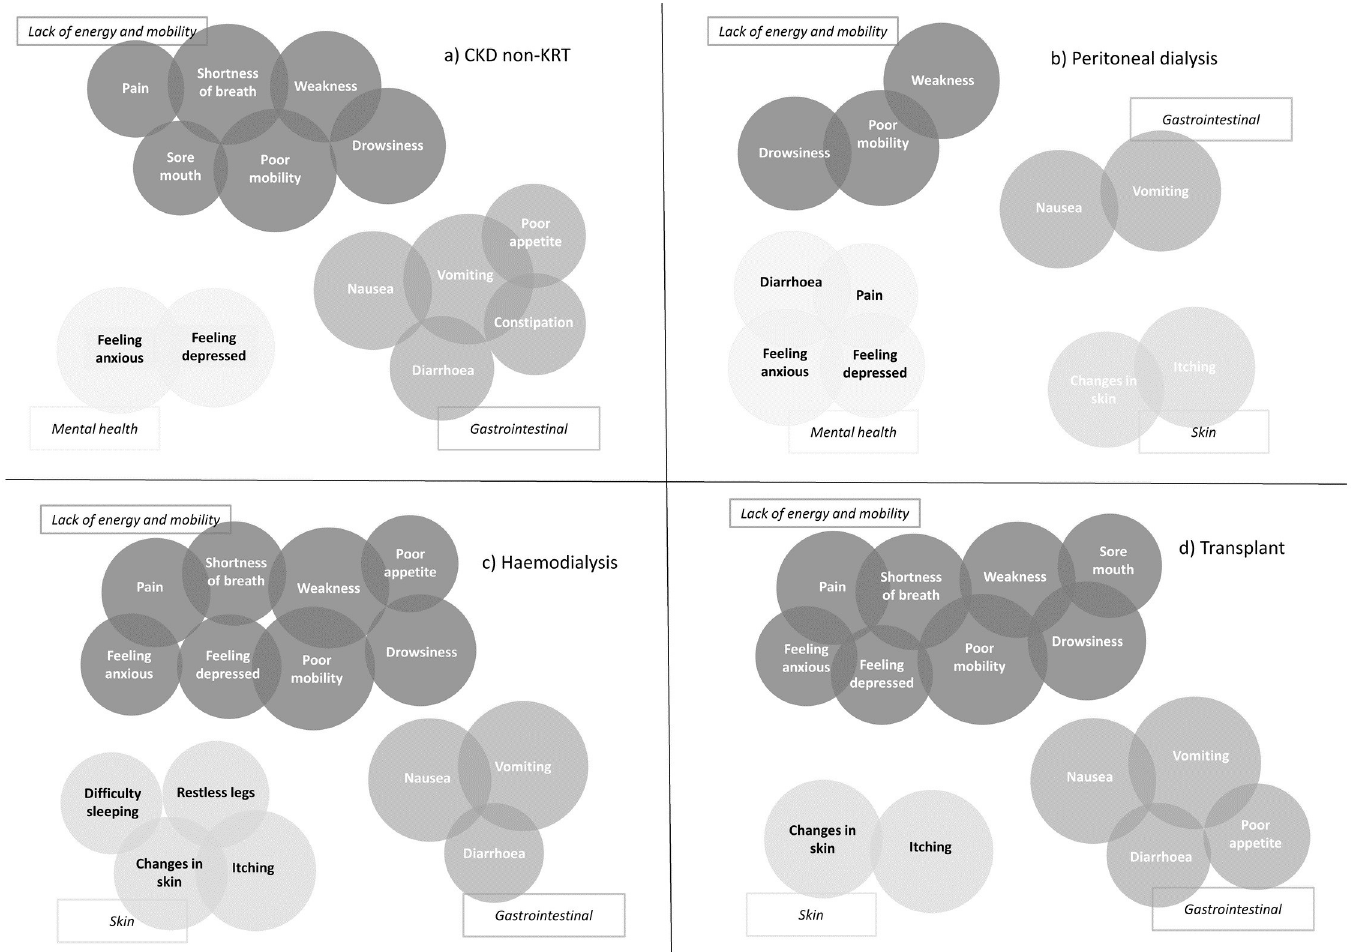
Fig 2. Symptom clusters from principal component analyses (PCA), stratified by treatment group; (a) CKD non-KRT, (b) peritoneal dialysis, (c) haemodialysis and (d) transplant. The size of the circles is proportional to the PCA loading which indicates how prominent the variable is within that cluster.